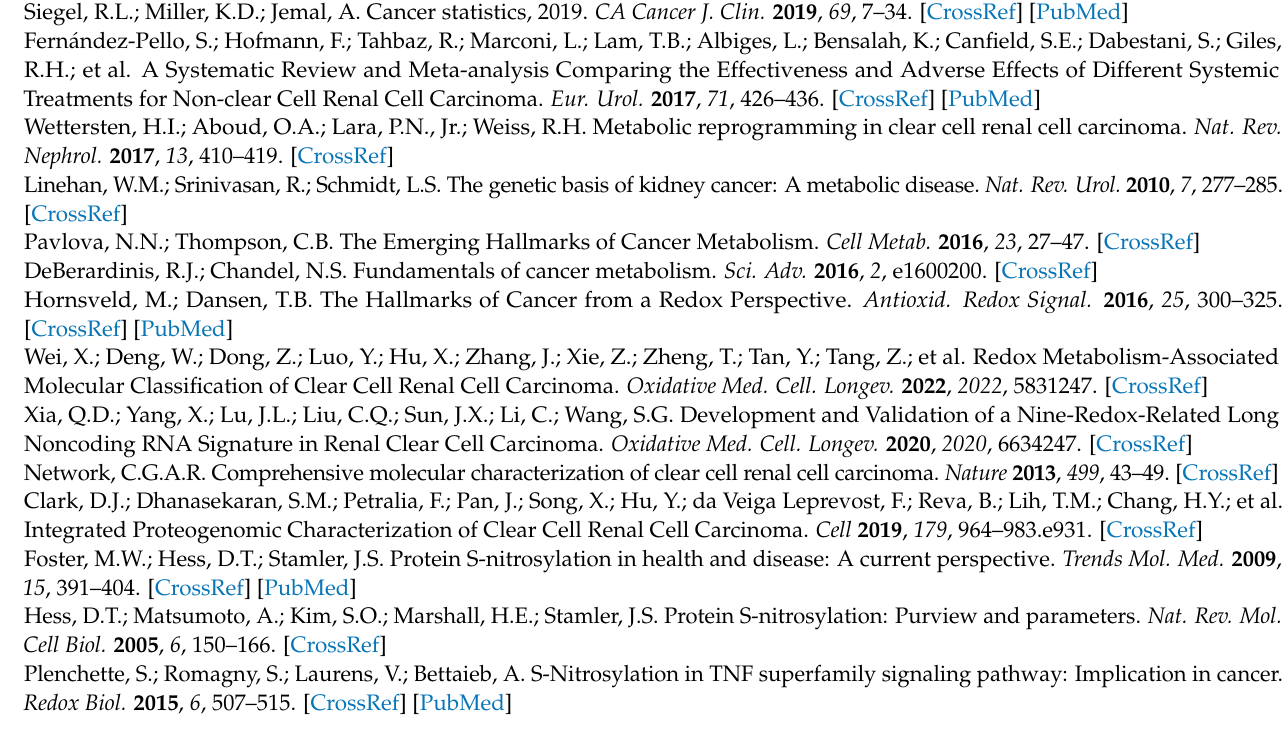
ClueGO results of differentially expressed SNO − proteins; Table S19: Expression matrix of 22 redox metabolites; Table S20: VIP values of redox metabolites; Table S21: Sample correlation assessment of the redox metabolites; Table S22: Pearson correlation assessment of the redox metabolites; Table S23: ROC curve evaluation of redox